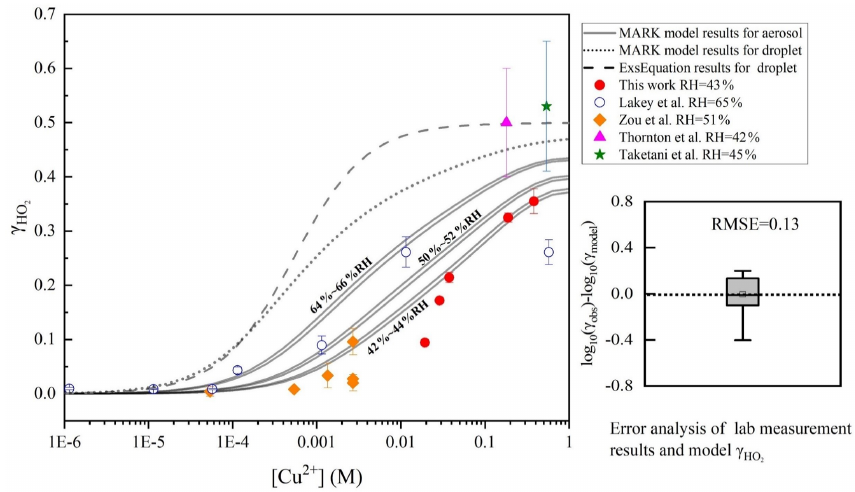
Figure 2. Dependence of γ HO on aerosol copper concentration. Red filled circles denote the results at 43% RH measured at Leeds included 2 in this paper. Blue hollow circles at 65% RH (Lakey et al., 2016b). Yellow filled diamonds denote results at 51% RH (Zou et al., 2019), filled purple triangle at 42% RH (Thornton and Abbatt, 2005), and filled green star at 45% RH (Taketani et al., 2008). The dashed grey line denotes the results of the classical parameterized equation (named CEq. in this paper) γ HO with deliquesced aerosol particles (Thornton 2 et al., 2008; Hanson et al., 1992, 1994; Jacob, 2000; Kolb et al., 1995), which was confirmed by research studies of reactive gas molecular uptake on dilute solution droplets (Magi et al., 1997) and on aqueous surfaces (Utter et al., 1992; Müller and Heal, 2002; Hu et al., 1995). The solid grey lines represent the model results of the MARK model in this study at various RHs (two lines represent the range of RH from 64% to 66%, 50% to 52%, and 42% to 44%), and the short dotted line represents the result in the MARK model of HO 2 with dilute solution droplets. The root mean square error (RMSE) between the MARK modelled values and the full dataset is 0.13. The aerosol pH is set as 4.5 based on the aqion 7.0.8 interface, considering the participation of Cu ions (for details, please see https://www.aqion.de/, last